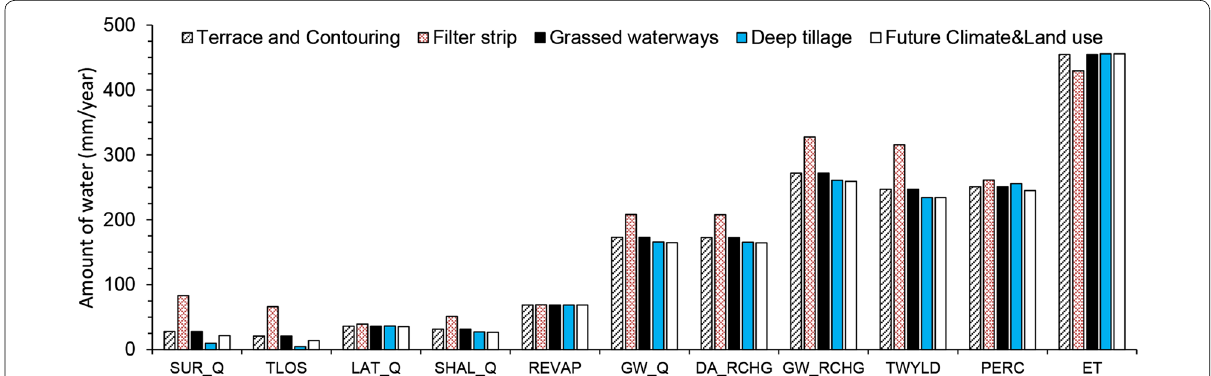
Fig. 23 Water balance under specific land and water management scenarios compared to the reference water balance scenario derived from near- term